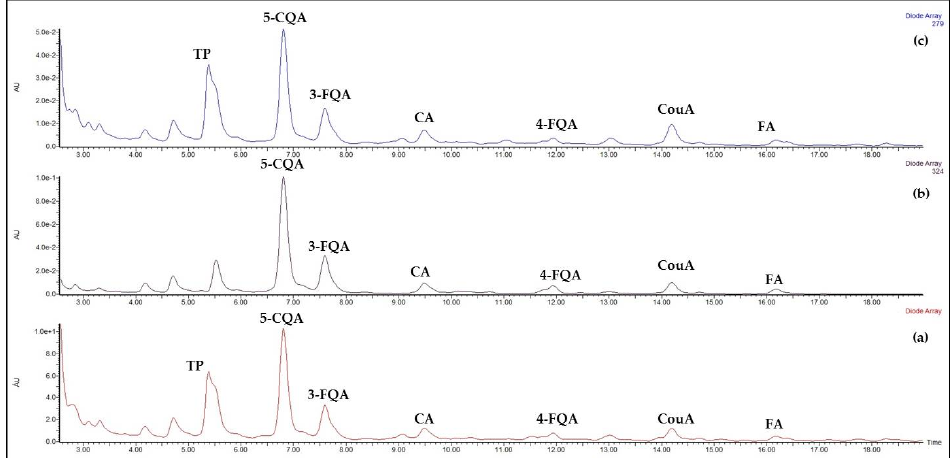
Figure 2. AR2 herbal tea diluted 1:10 with mobile phase: ( a ) PDA chromatogram; ( b ) EC at λ = 324 nm; ( c ) EC at λ = 279 nm. TP: tryptophan; 5-CQA: 5-caffeoylquinic acid; 3-FQA: 3-feruloylquinic acid; CA: caffeic acid; 4-FQA: 4-feruloylquinic acid; CouA: coumaric acid; FA: ferulic acid.